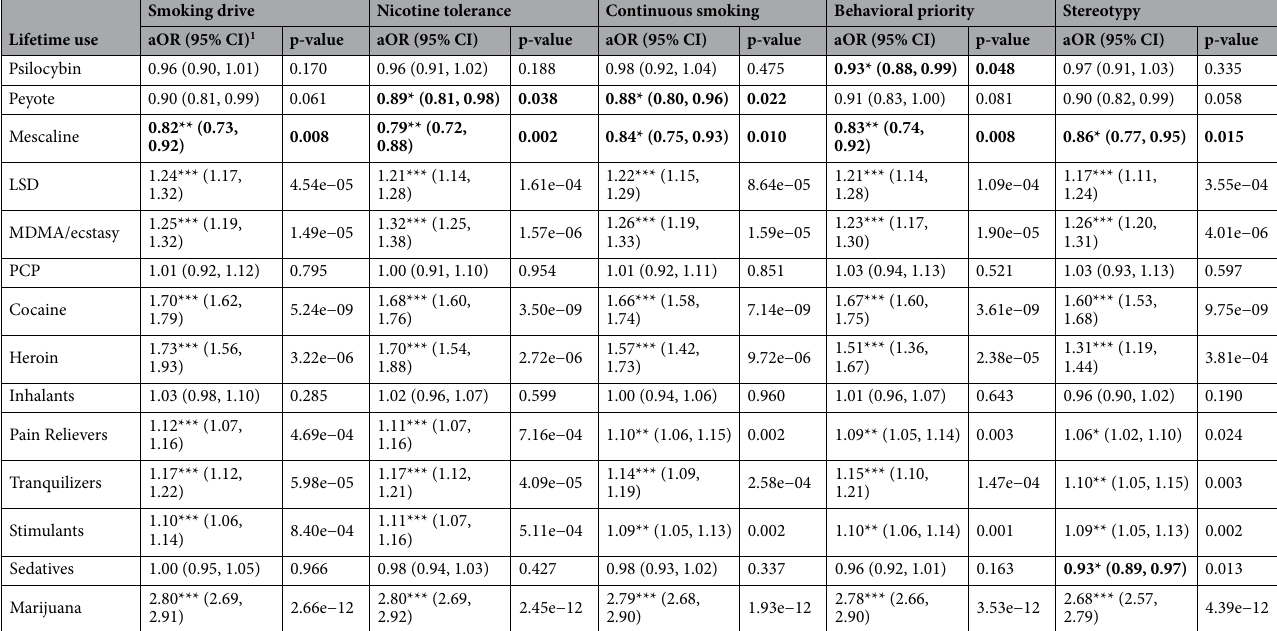
Table 3. Associations between lifetime substance use and the five NDSS subdomains. Significant values conferring lowered odds of nicotine dependence are in bold. 1 *p < 0.05; **p < 0.01; ***p < 0.001, aOR adjusted odds ratio, CI confidence